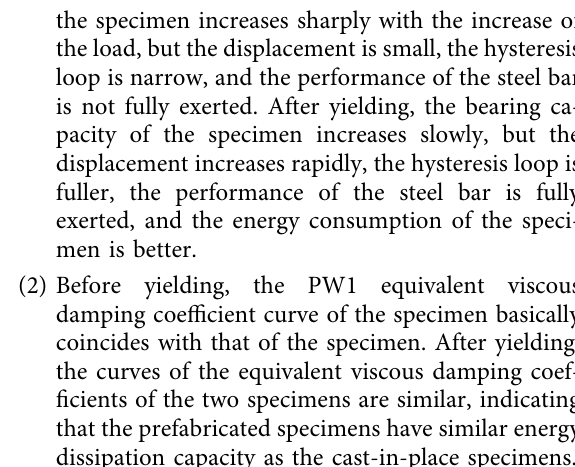
Figure 4: Equivalent viscous damping coefficient-vertical hori- zontal displacement curve of each